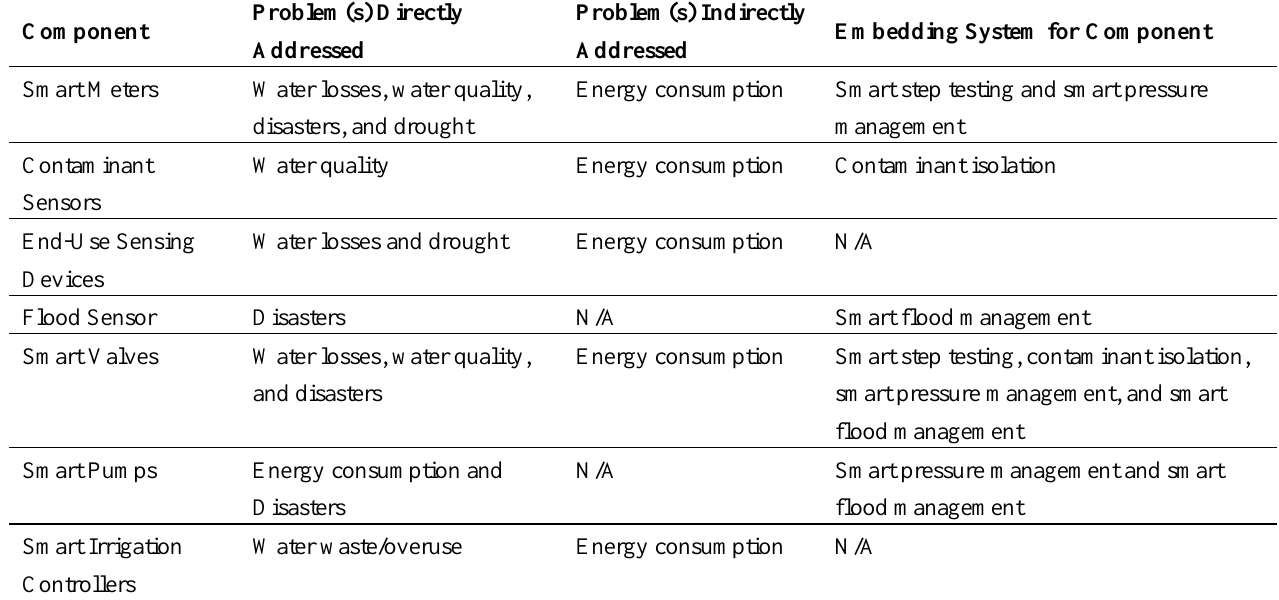
Table 1. Components of the smart water grid, problems each component can address, and the smart systems that components are part